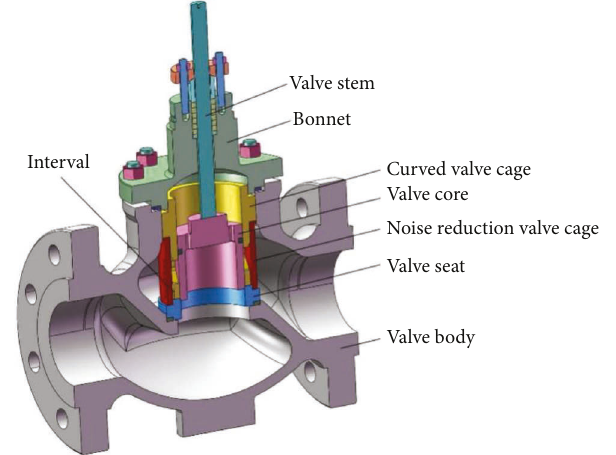
Figure 8: Ball valve